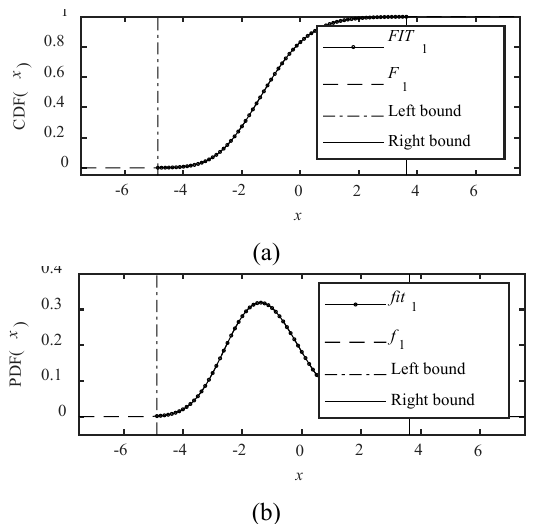
Fig. 3. Fitting graphic of first-order Tracy-Widom distribution.